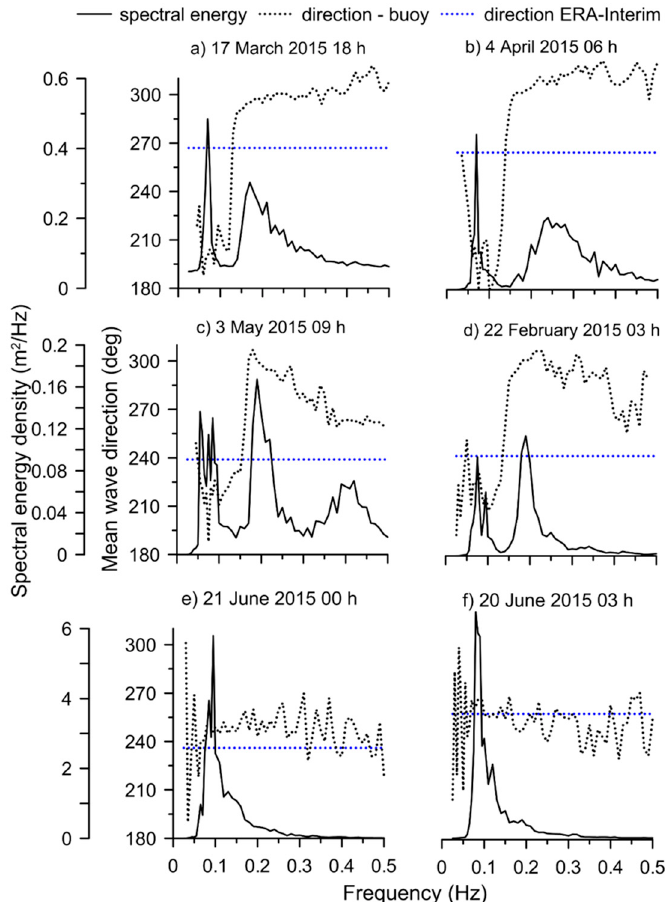
Figure 10. Plots showing the wave spectral energy density and mean wave direction from measured buoy data during different wave conditions along with ERA ‐ Interim wave direction. ( a ) and ( b ) are swell ‐ dominated multi ‐ peaked wave spectra, ( c ) and ( d ) are wind ‐ sea dominated multi ‐ peaked wave spectra, and ( e ) and ( f ) are single ‐ peaked spectra during the